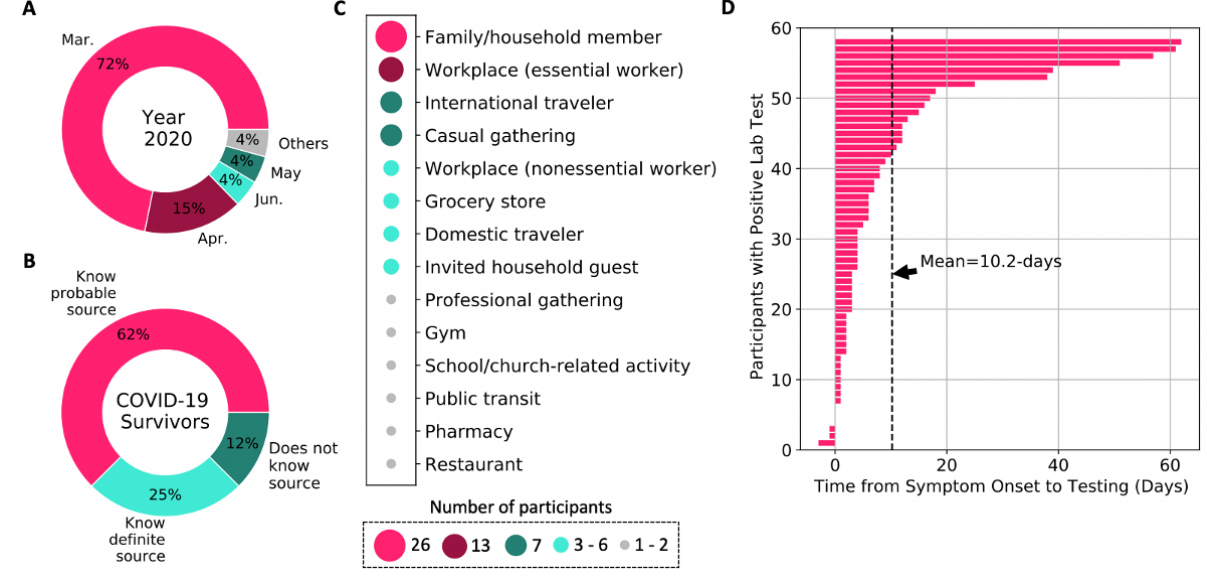
Figure 1. Overview of COVID-19 onset, testing, and contraction for participants in this study. (A) Month of symptom onset; (B) knowledge about the source of infection; (C) prevalent sources of virus transmission; and (D) time lag from symptom onset to testing for